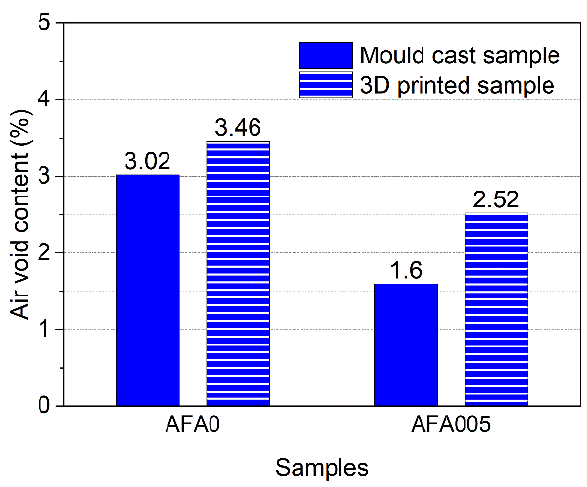
Figure 7. Air-void content of 3DPC at 28 days.